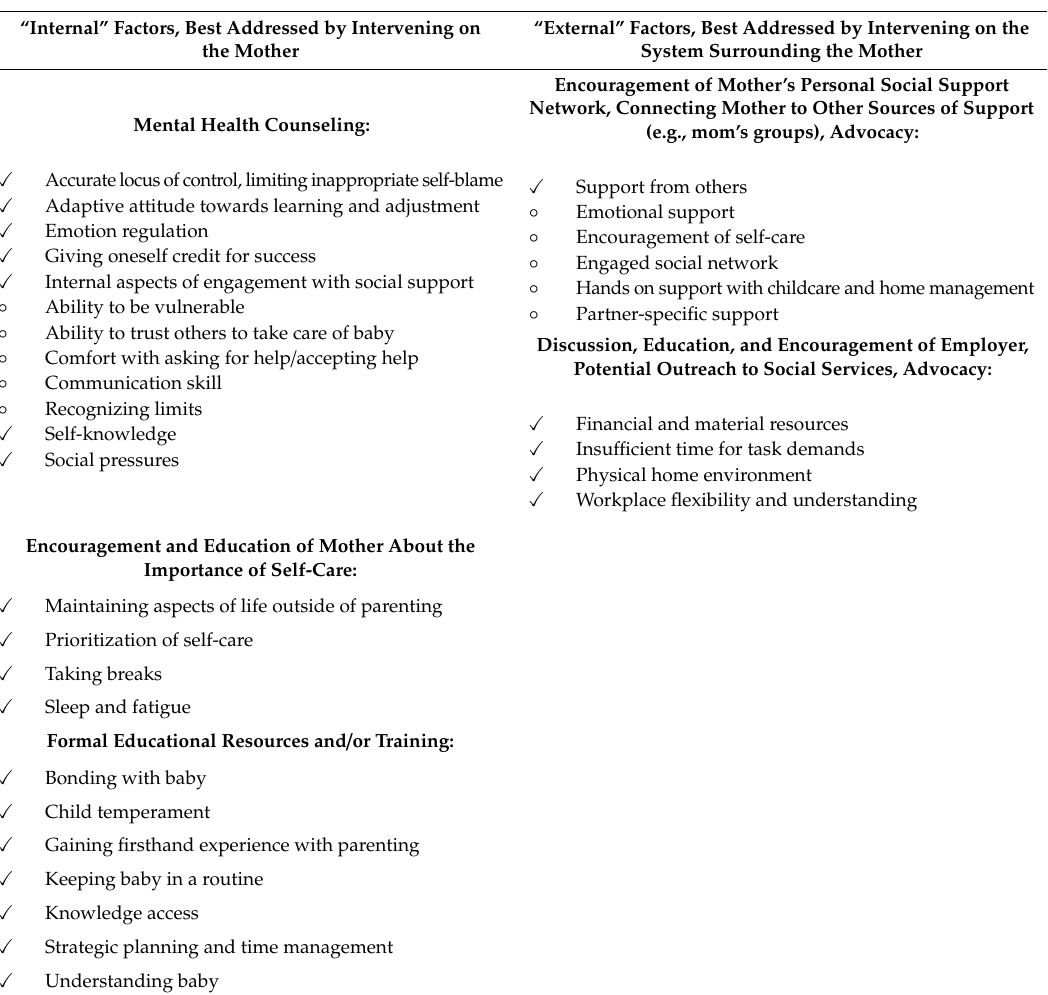
Table 3. Intervention taxonomy mapping the factors impacting maternal functioning to interventions through which they may be